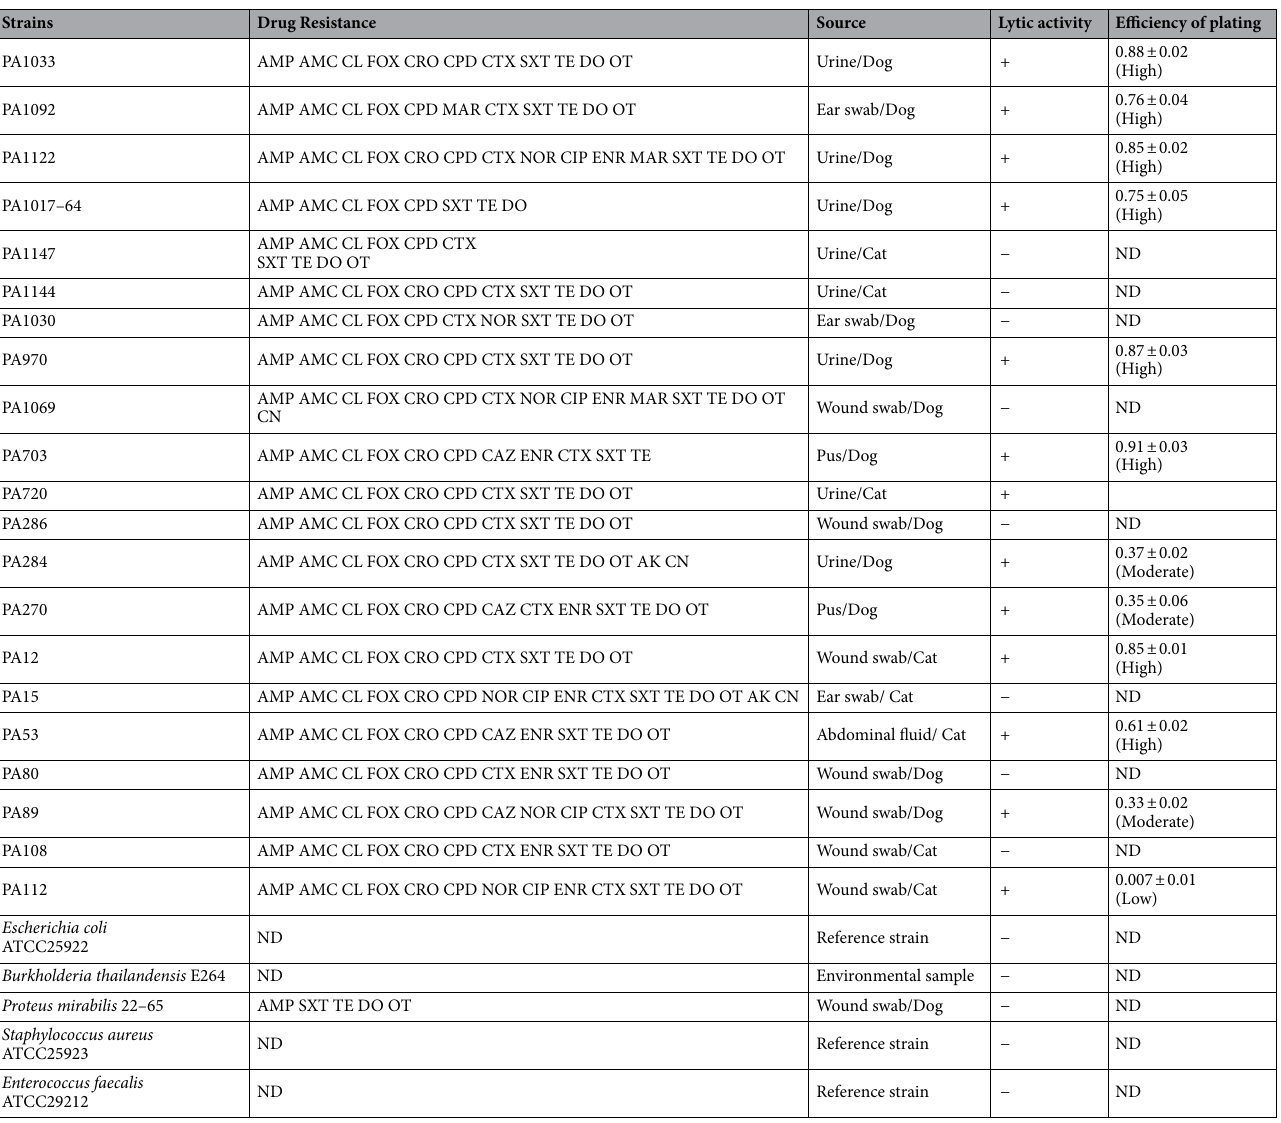
Table 1. Host range infection and EOP of phage vB_PaeS_VL1 against 61 Pseudomonas and other bacteria. The lytic activity was determined by plaque assay. The results “ + ” indicates lytic or susceptibility; “ − ” indicates non − lytic or resistant; ND = Not